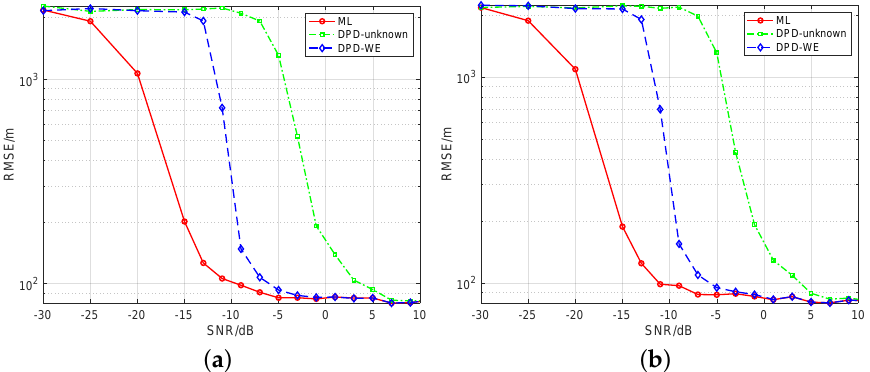
Figure 7. RMSE vs. SNR for the three localization algorithms of maximum likelihood (ML), DPD- unknown and DPD-WE with transmitting Gaussian pulses of noncoherent and coherent modulations: ( a ) noncoherent modulation, ( b ) coherent